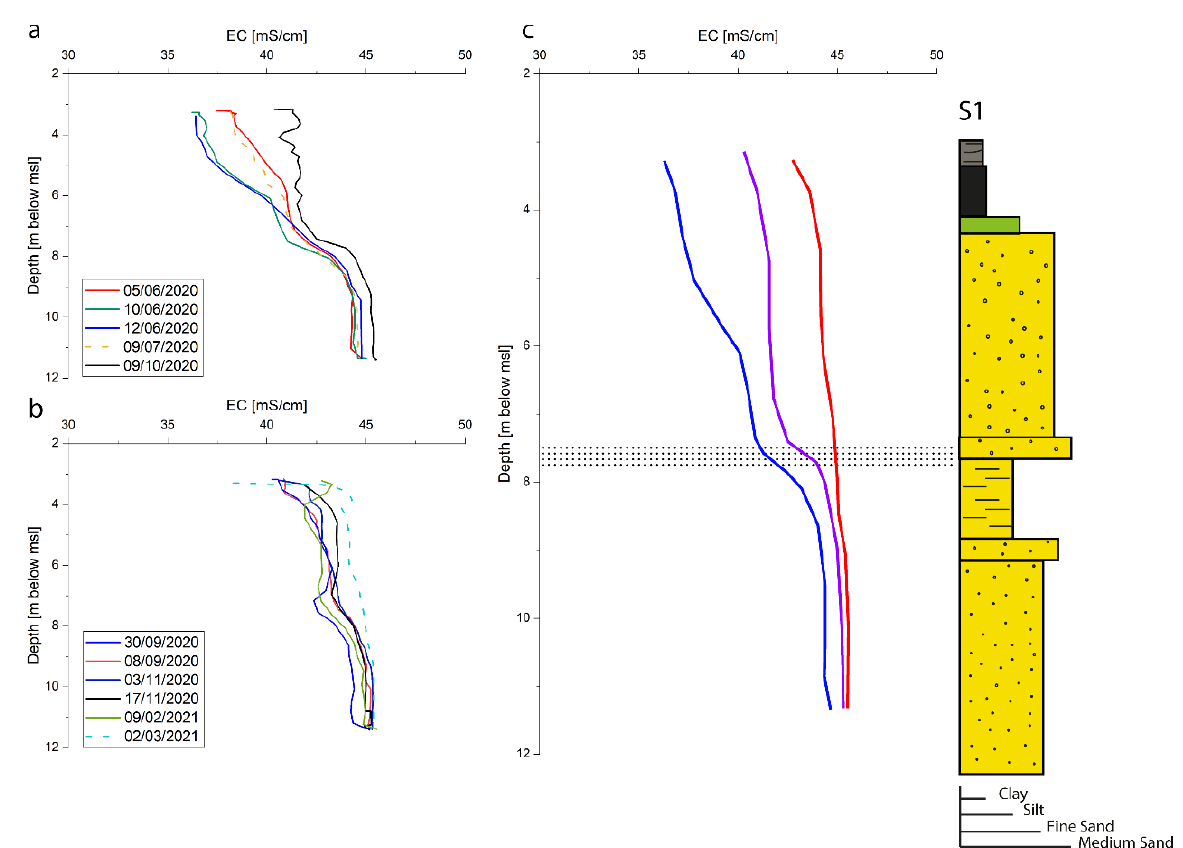
Figure 8. EC profiles collected in S1 well. Panels ( a , b ) show the configurations assumed by the EC curve during the observed period. The model of panel ( c ) summarizes the configurations and compares them with the stratigraphic section, outlining the sedimentary constraint (dotted area) existing in the subsoil surrounding the monitoring point.